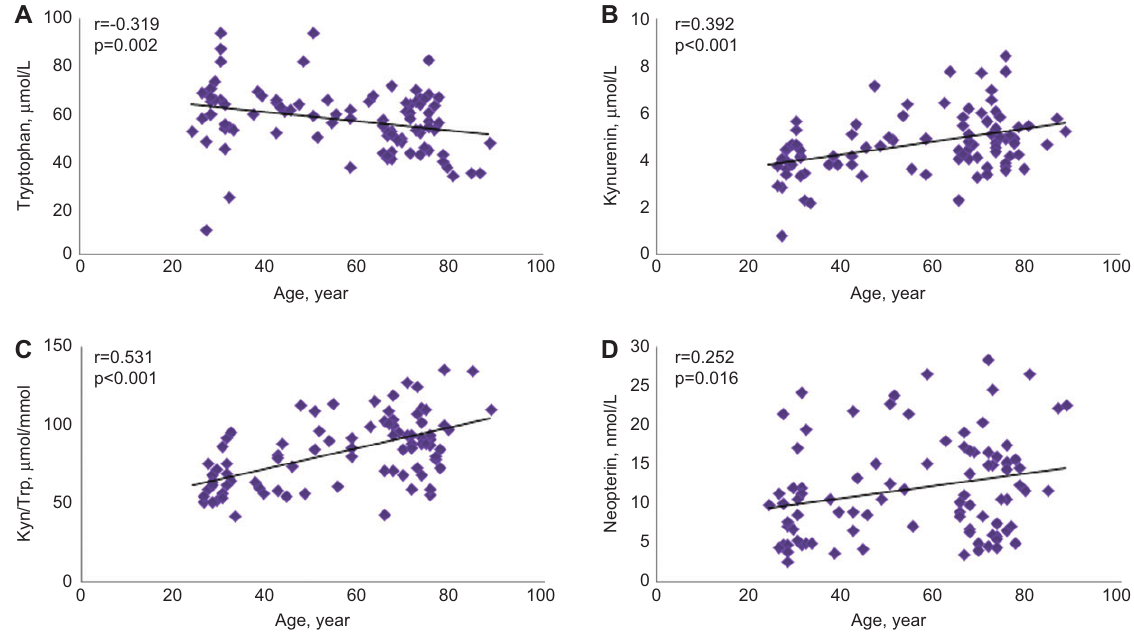
Figure 2 Alteration of serum tryptophan (A), kynurenine (B), Kyn/Trp (C) and neopterin (D) concentrations by age (*p < 0.05).